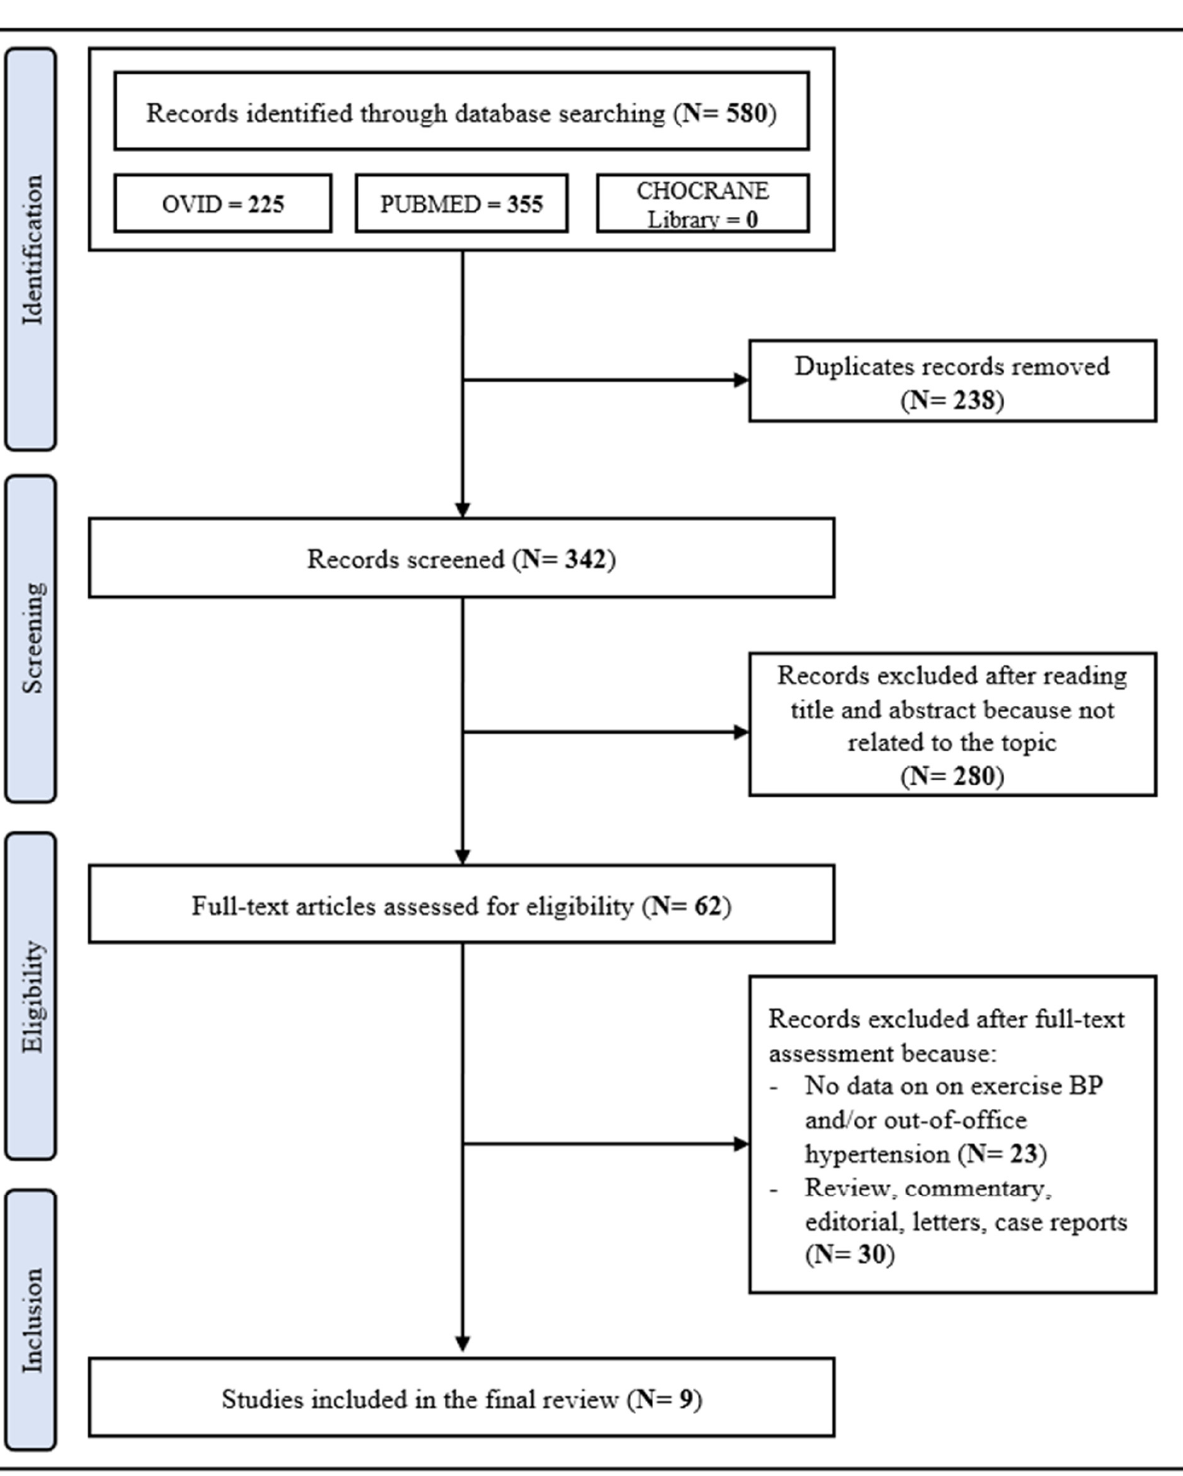
Figure 1. Schematic flow-chart for the selection of studies.